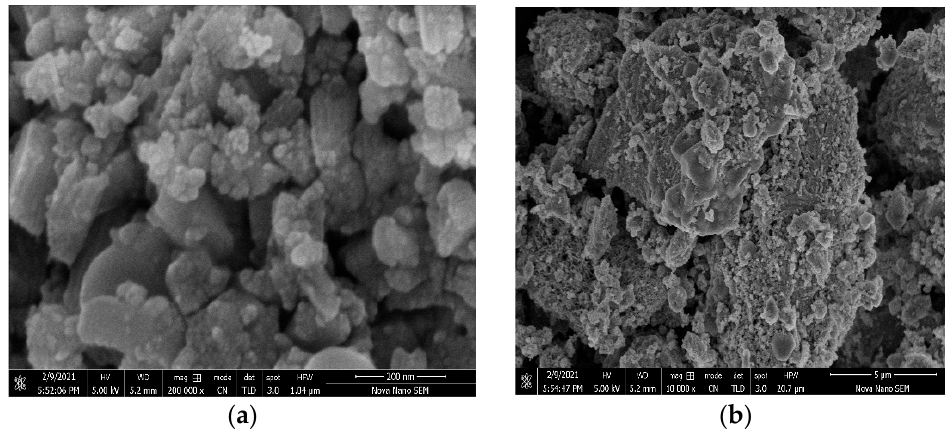
Figure 7. SEM images of prepared nano-catalysts of ICdO + ISnO. ( a ) SEM image of ICdO + ISnO taken at 200 nm, ( b ) SEM image ICdO + ISnO taken at 5 µm